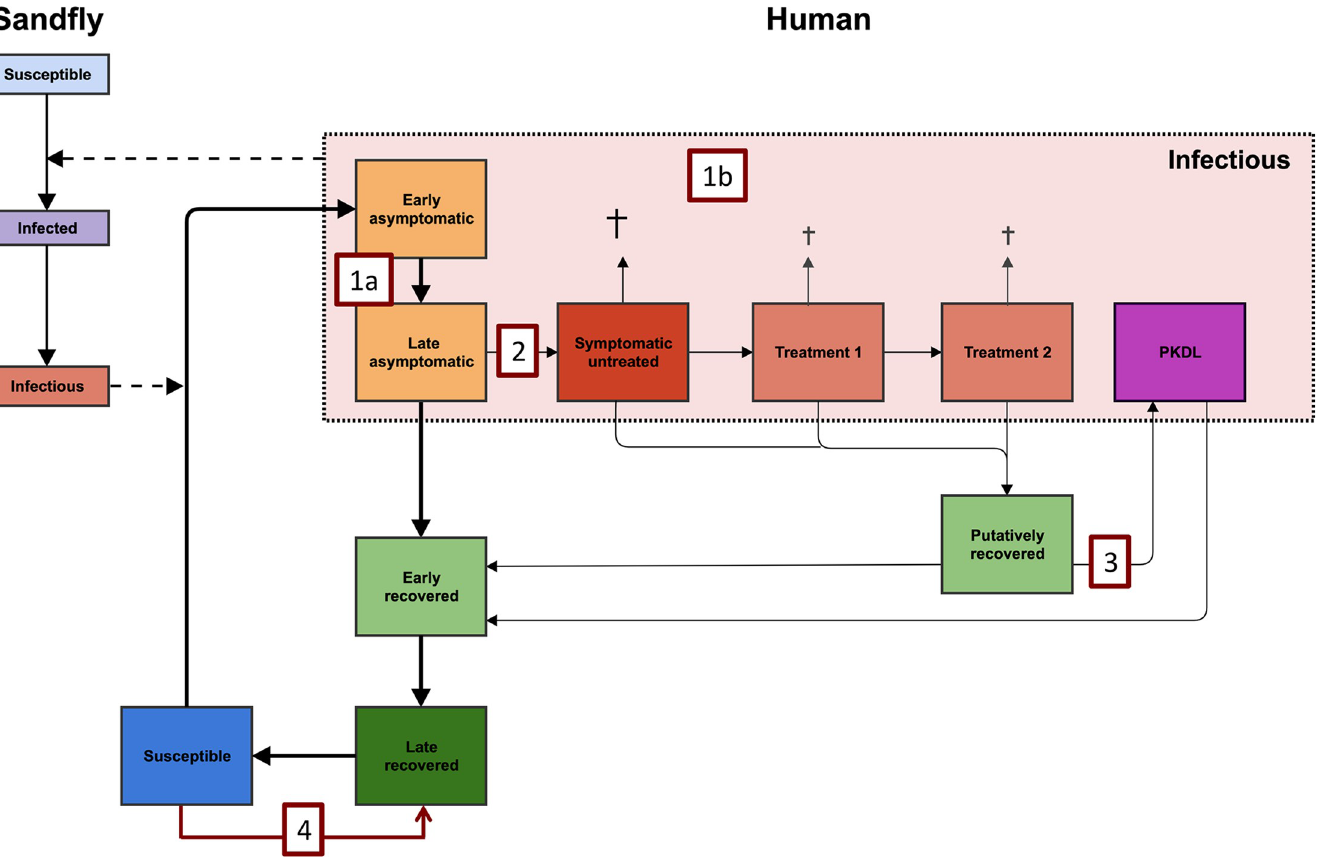
Fig 1. Schematic presentation of the model variant in which asymptomatic individuals contribute to transmission, with numbers related to different types of vaccine characteristics that are implemented in the models. In the alternative model variant, asymptomatic individuals are assumed not to be infectious towards to sand fly, with infection pressure only coming from symptomatic individuals with VL (with and without treatment) and PKDL. Once a susceptible individual is infected by an infectious sand fly, they become early asymptomatic for an average duration of about 200 days, which is followed by the late asymptomatic stage (average duration of 69 days). The average infectivity of both asymptomatic stages together is 0 in the model in which they do not contribute and ~1.5% relative to VL in the model in which they contribute to transmission. 1.4% of late asymptomatic individuals develops VL, and without active case detection, the duration between onset of symptoms and start of treatment lasts on average 40 days, followed by 1-day treatment 1 and potentially 28-day treatment 2 or death if left untreated. The average duration of the putatively recovered stage is 21 months and 5% of these individuals develop PKDL which lasts 5 years on average. The infectivity of PKDL is 90%, relative to VL. The rest recovers to the early recovered stage (average duration of 74 days), followed by the late recovered stage (average duration of 2 years), which can be interpreted as the duration of immunity. The numbers in the red boxes relate to the numbers in the first column of Table 1 and represent the following vaccine characteristics; 1a) early and late asymptomatic individuals become half as infectious, 1b) all infection states become half as infectious, 2) vaccinated individuals are 50% less likely to develop symptoms, 3) vaccinated individuals are 50% less likely to develop PKDL, and 4) vaccinated individuals develop transient immunity against infection.